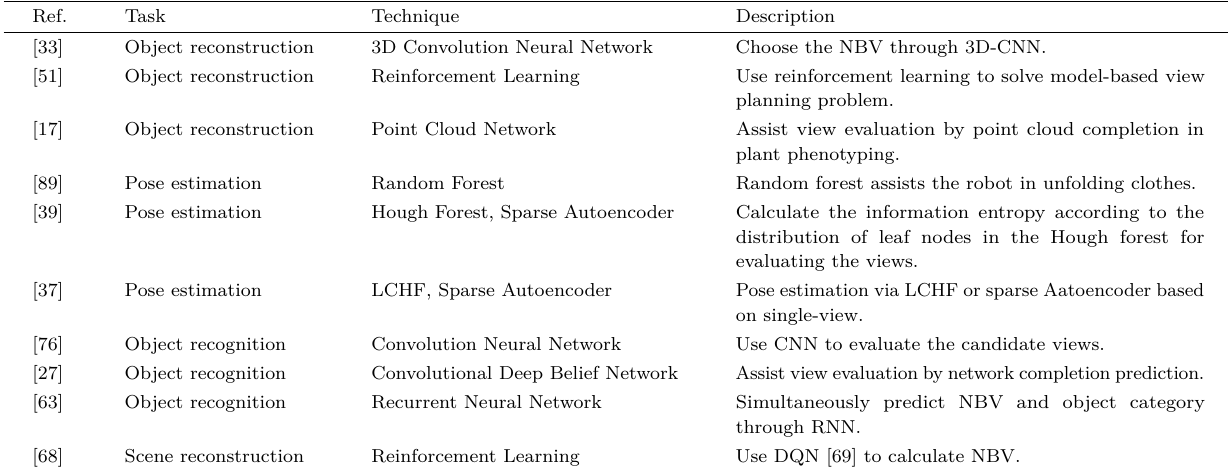
Table 3 View planning using traditional machine learning or deep learning Ref.